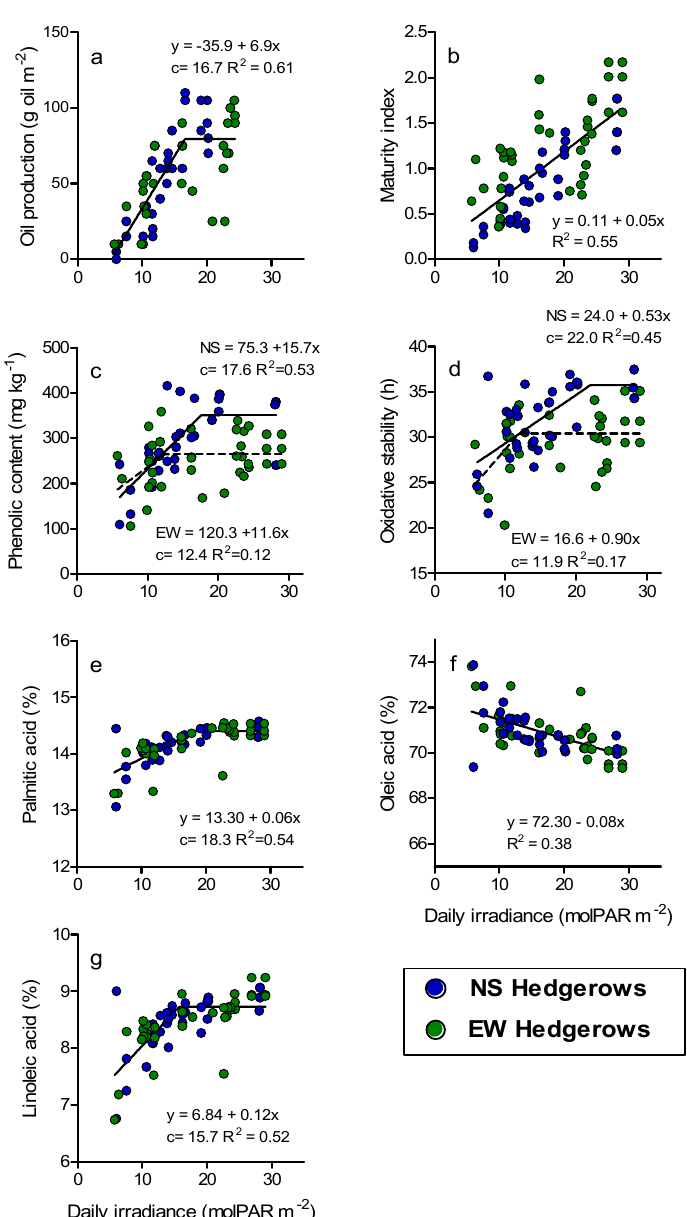
Figure 3. Response of oil production (panel a ), maturity ( b ), phenolic concentrations ( c ), oxidative stability ( d ) and main fatty acid composition ( e – g ) of olive oil obtained from mature fruits located at various heights on both sides of NS and EW hedgerows planted at three row spacings (5.0, 3.75 and 2.5 m) in relation to simulated foliage irradiance. Each point is the average for the 2012 and 2013 seasons. Parameter c is the daily irradiance at which the relationship changes slope. Data from NS hedgerows included in plots ( e – g ) are adapted from Trentacoste et al. [17]. A bilinear model fitted the relationship between oil production and irradiance for data from all hedgerow spacings and orientations. The linear response (R 2 = 0.61; p < 0.01) terminated with a threshold of 16.6 mol PAR m − 2 .